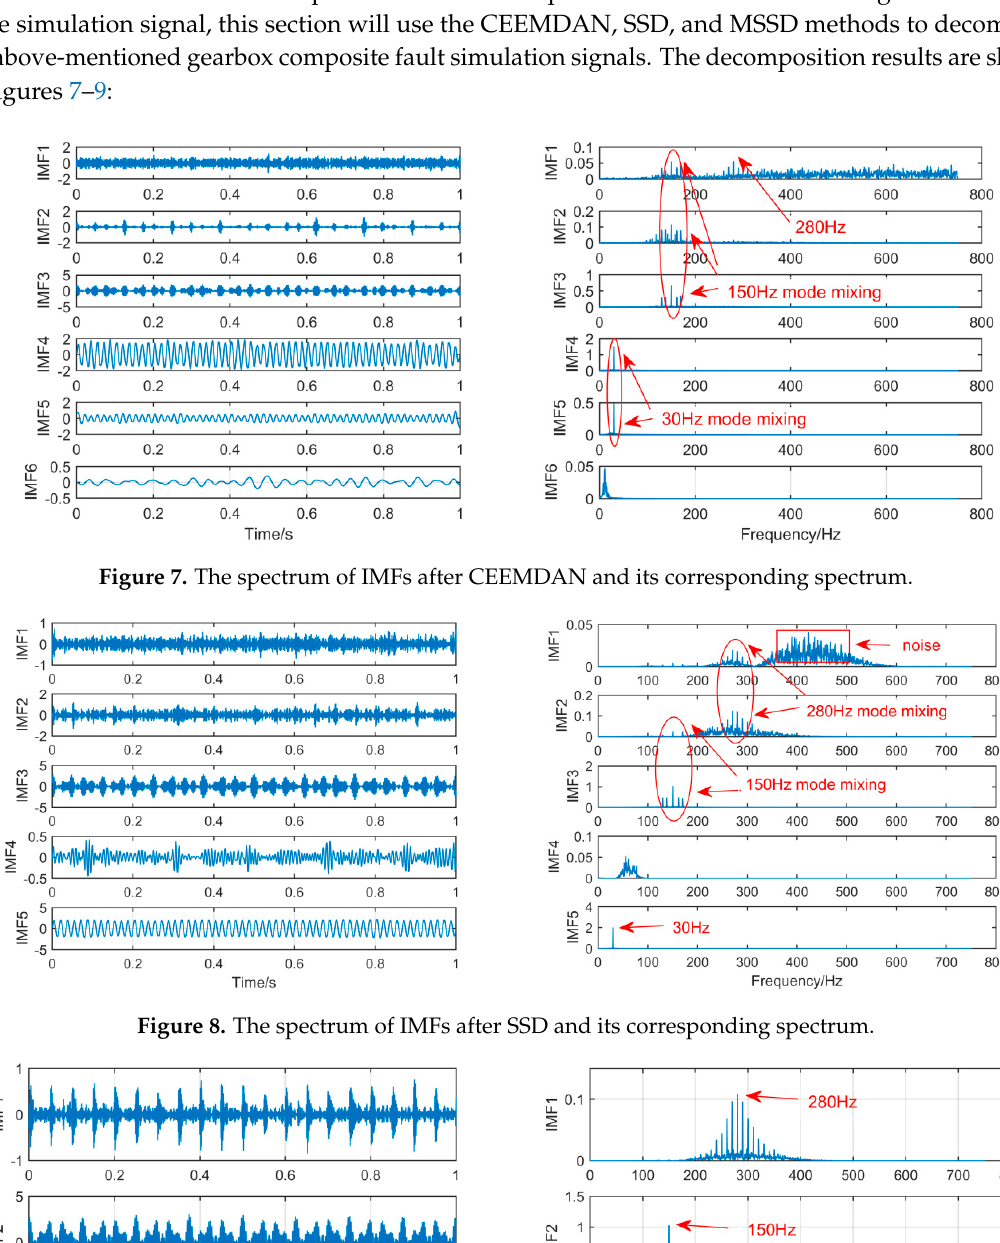
Figure 6. The time domain waveform of each component signal and simulation signal.